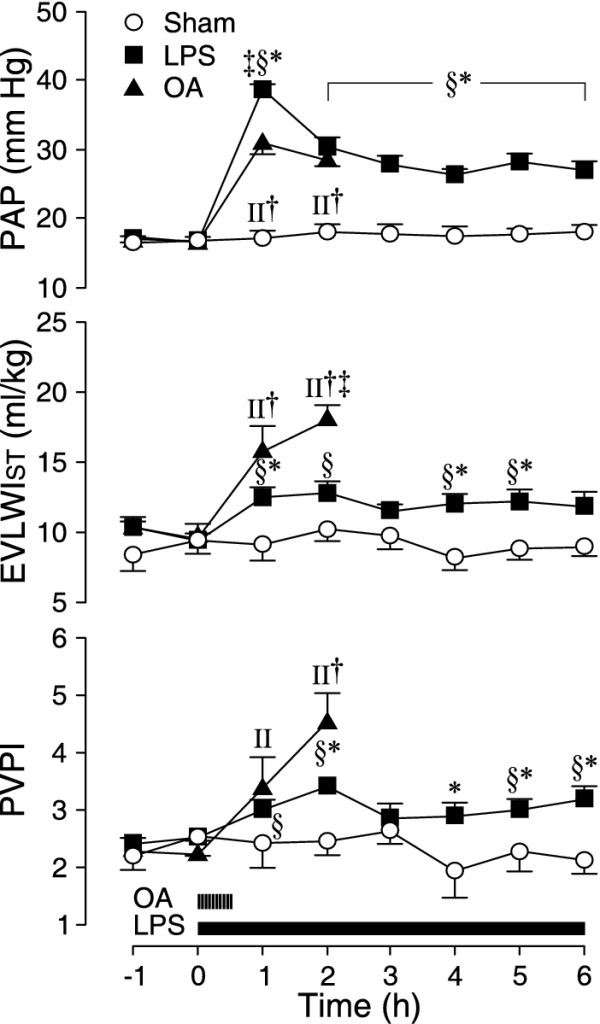
Changes in pulmonary haemodynamics and extravascular lung water in sheep. Data are expressed as mean ± standard error of the mean. *P < 0.05, LPS versus sham-operated group; †P < 0.05, OA versus sham-operated group; ‡P < 0.05, LPS versus OA group; §P < 0.05, versus t = 0 hours in LPS group; llP < 0.05 versus t = 0 hours in OA group. EVLWIST = extravascular lung water index measured by single thermodilution; LPS = lipopolysaccharide; OA = oleic acid; PAP = pulmonary arterial pressure; PVPI = pulmonary vascular permeability index; Sham = sham-operated group.